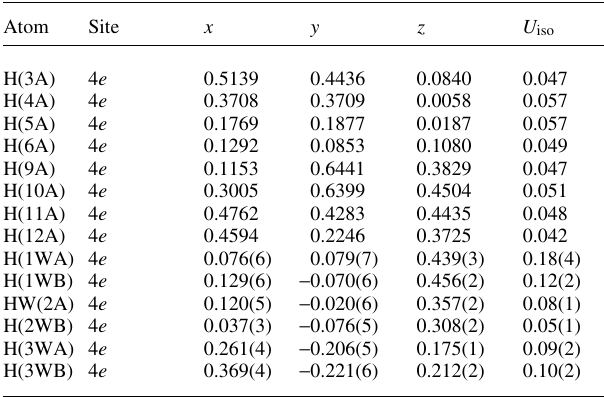
Table 2. Atomic coordinates and displacement parameters (in Å 2 )